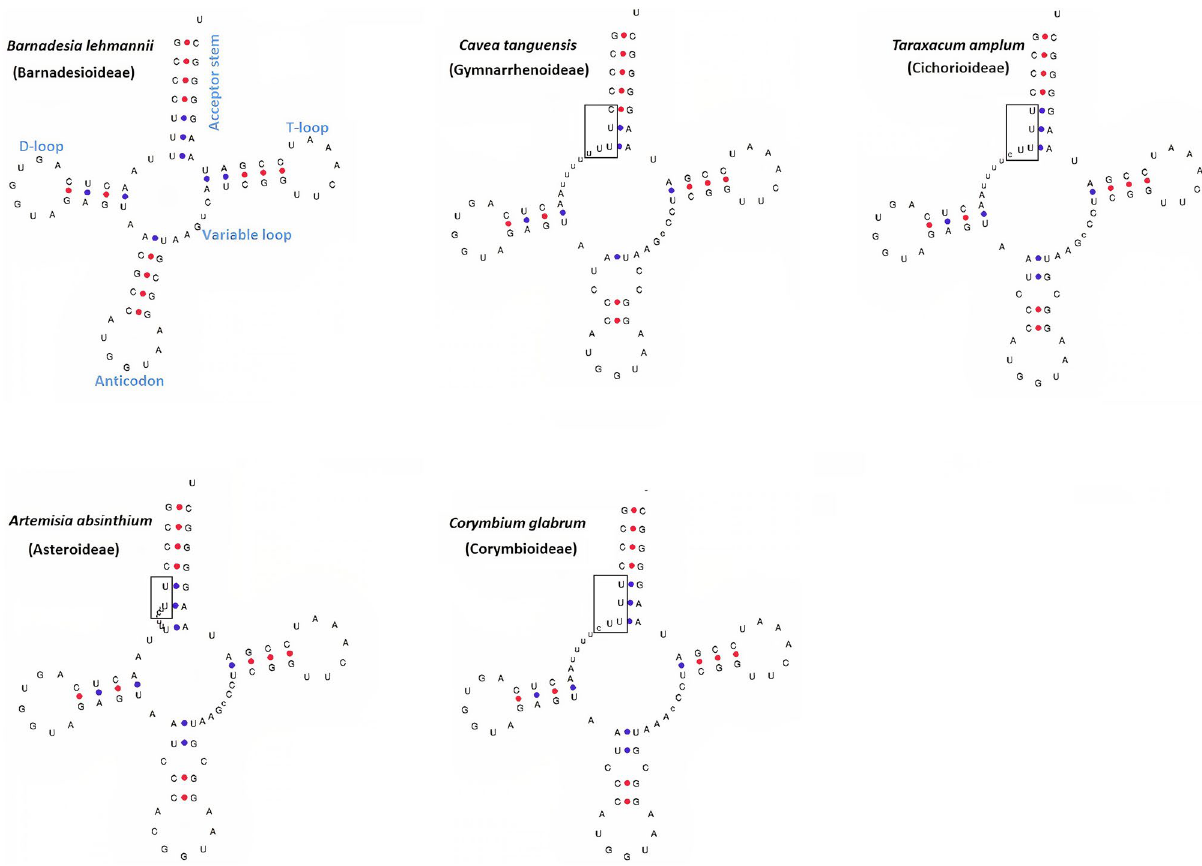
Figure 2. Structure of trn T-GGU gene of species of 13 subfamilies. One species was taken from each subfamily of core Asteraceae. The trn T-GGU gene of Barnadesia lehmannii is labeled to show the functional parts as representative of all species. The perfect clover leaf structure of trn T-GGU exists in the species of nine subfamilies, including Barnadesioideae, Famatinanthoideae, Stifftioideae, Mutisioideae, Gochnatioideae, Wunderlichioideae, Hecastocleidoideae, Pertyoideae, and Carduoideae. The B. lehmannii represent the structure of trn T-GGU of the species of all nine subfamilies. The insertion occurred in the species of four subfamilies of core Asteraceae (Gymnarrhenoideae, Cichorioideae, Corymbioideae, and Asteroideae), which also correspond to mismatches above the anticodon loop. The insertion is highlighted with a whereas the other endpoint is present between trn E-UUC and trn T-GGU 36 . However, the absence of pseudogeni-